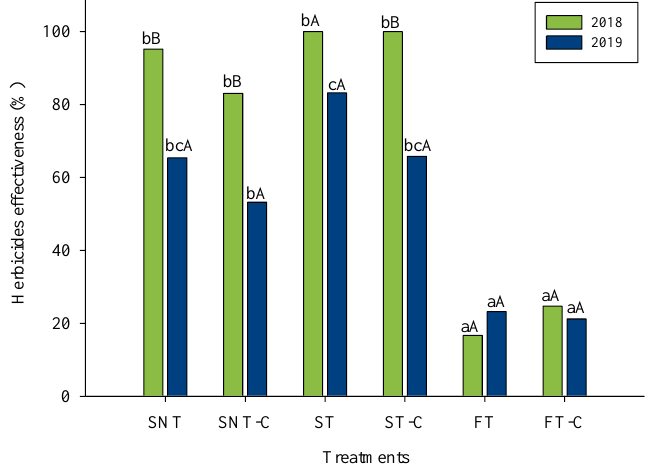
Figure 1. Effects of different management systems on herbicides effectiveness. Different letters indicate differences ( p < 0.05) between treatments in the same year (lower case letters) and between years within the same treatment (upper case